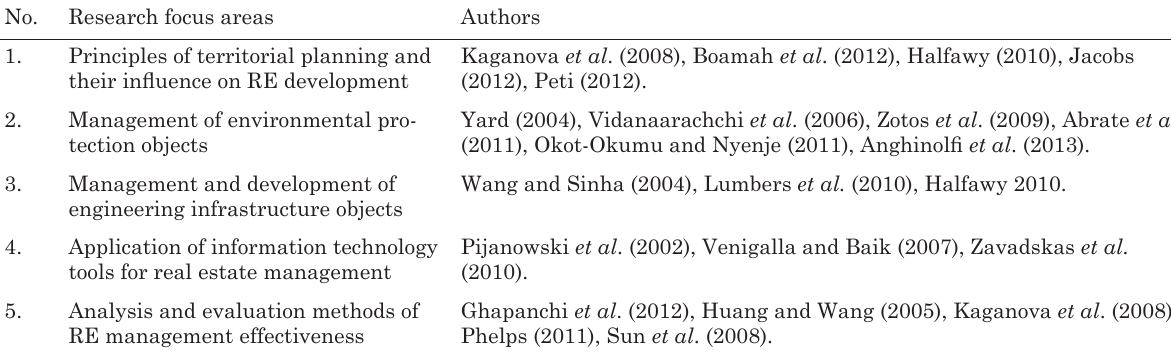
Table 1. Main directions of scientific research on municipal RE